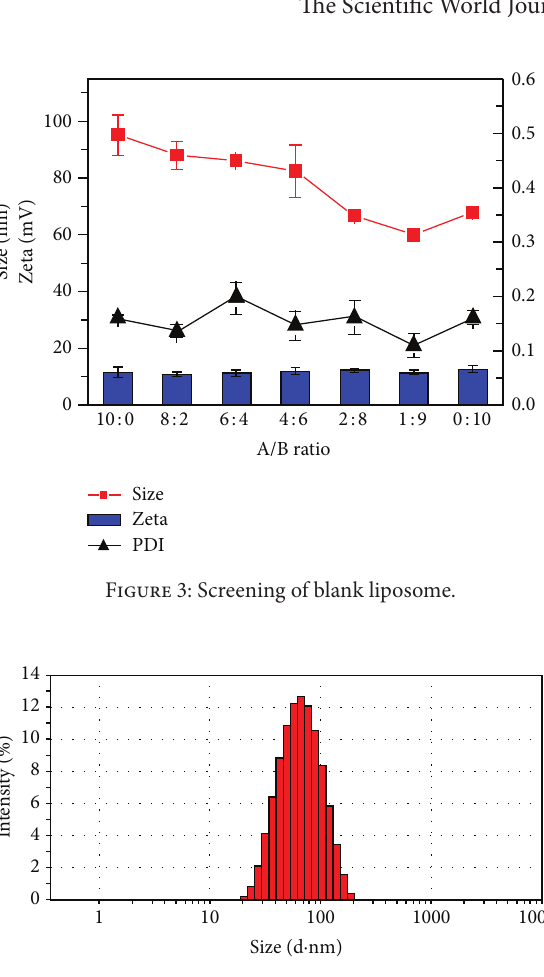
Figure 4: Size distribution of RGD-PTX